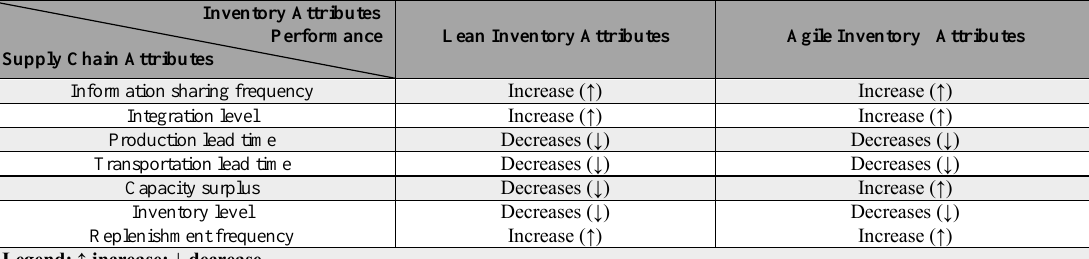
Table 1. Lean and agile SCM synergies and divergences